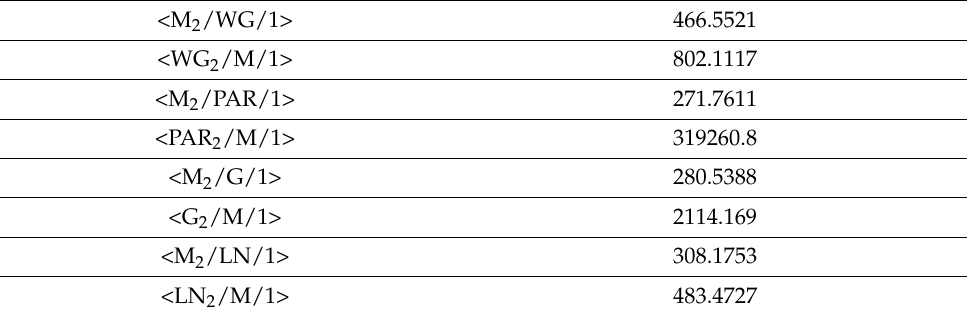
Table 2. Estimated values of the MTTF of the system ˆ ET .